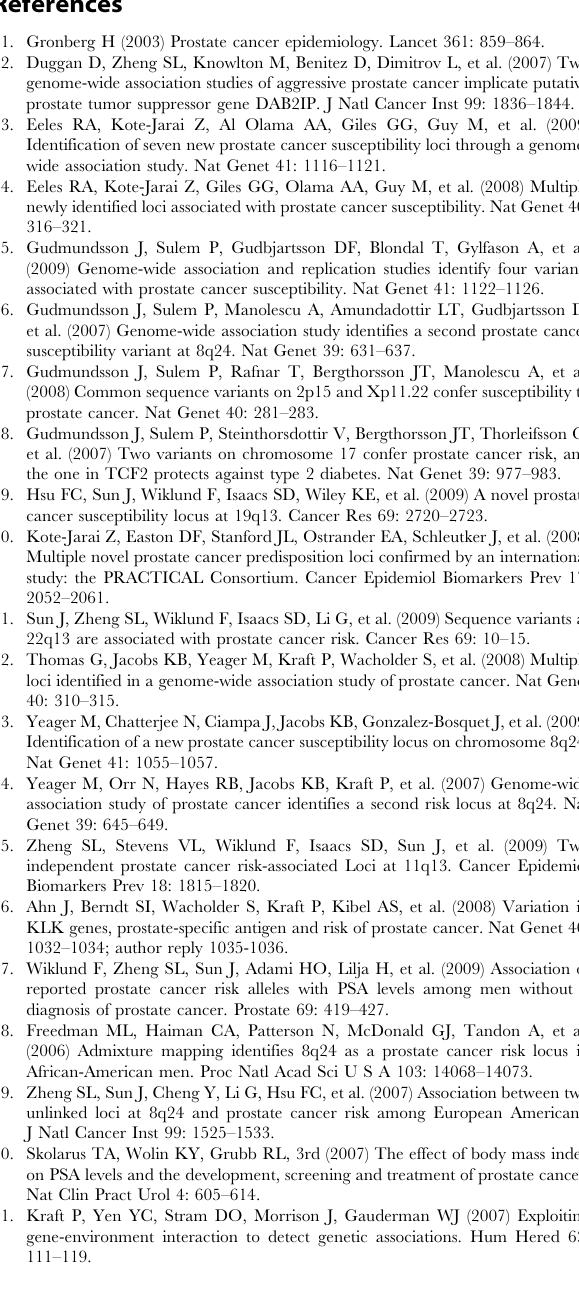
Table S7 Association between alcohol consumption and pros- tate cancer risk stratified by SNP genotypes. Table S8 Pair-wise SNP-SNP interactions that reached a p-value ,